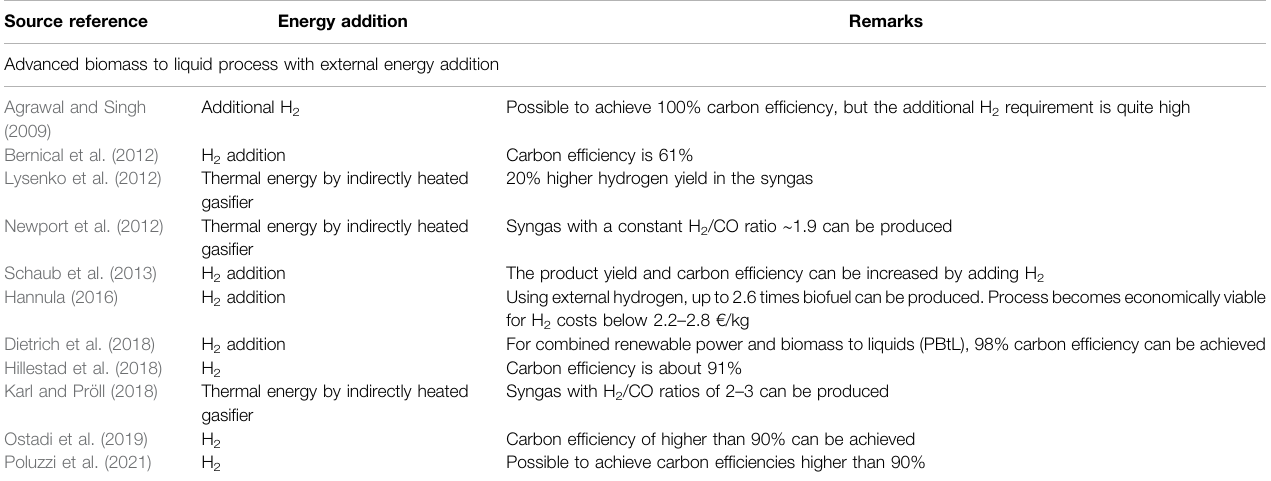
TABLE 2 | Literature survey for the BtL process with external energy